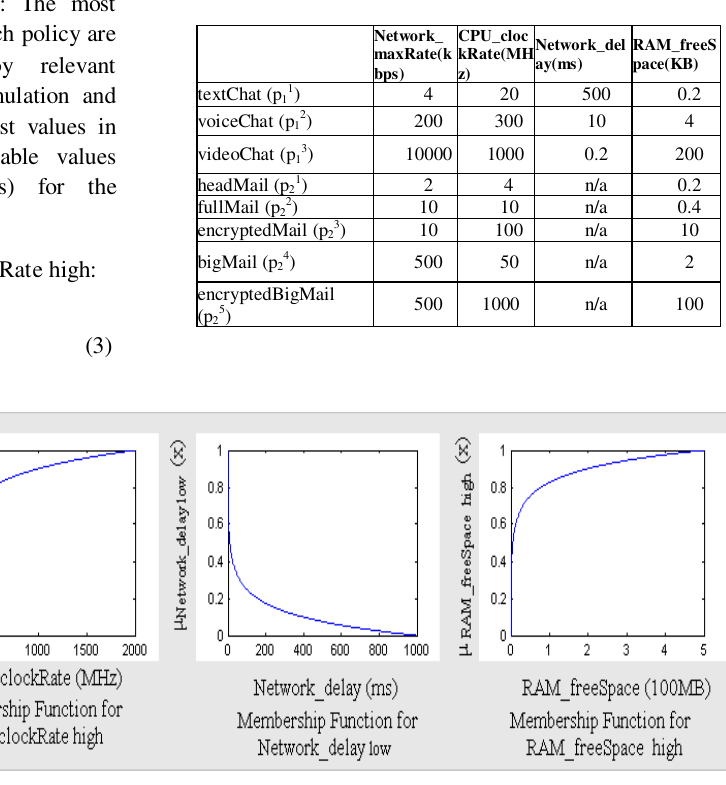
Table 1 Most Suitable Context Values for the Policies